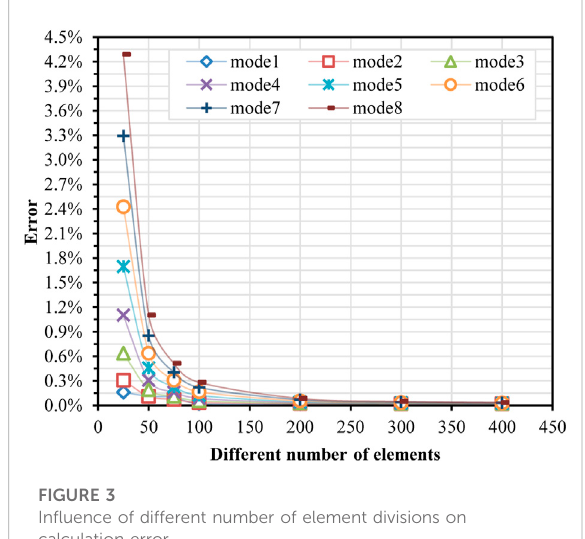
FIGURE 3 In fl uence of different number of element divisions on calculation